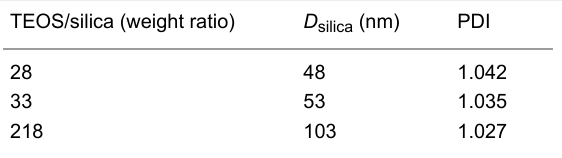
Table 2: Experimental conditions of the silica particles synthesis and size measurement results of the silica particles obtained (as extracted from statistical analysis of TEM